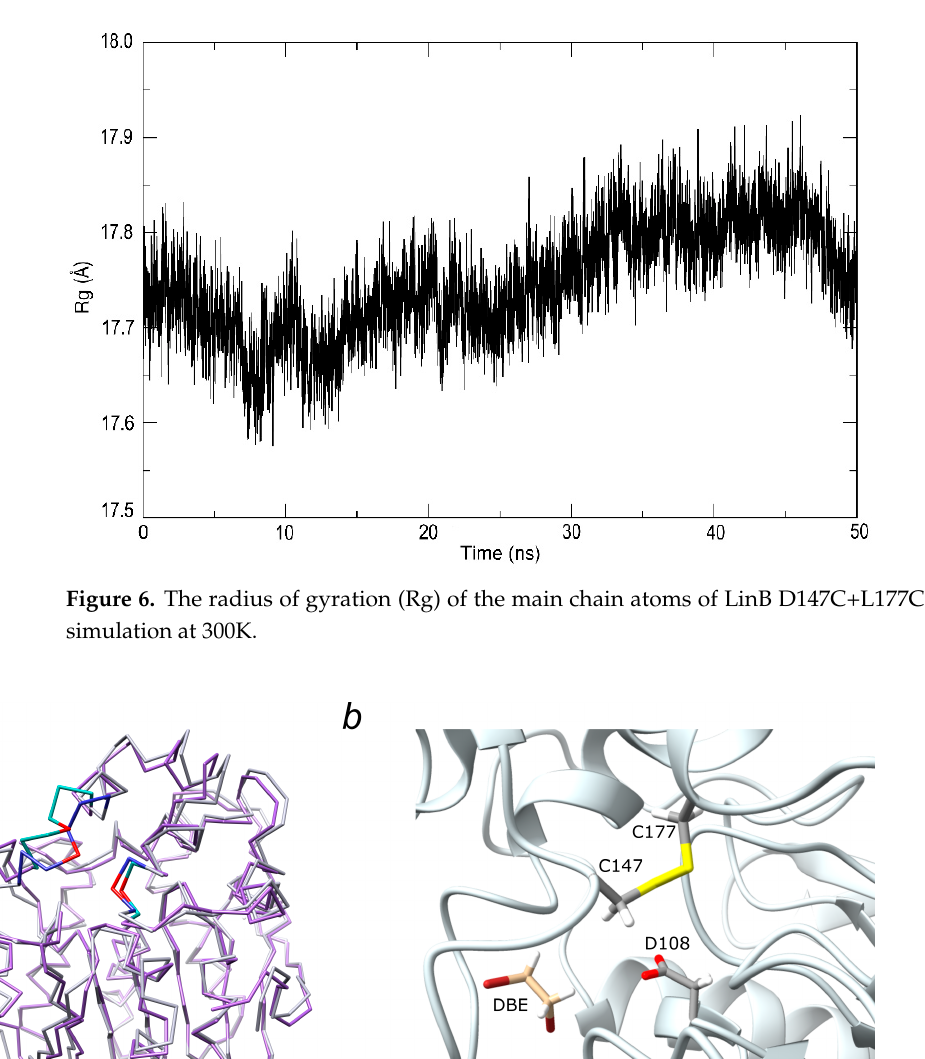
Figure 8. LinB access tunnels in ( a ) LinB WT (PDB ID: 2bfn, [18]), ( b ) LinB D147C+L177C crystal structure (PDB ID: 6s06, this study), and ( c ) LinB MD D147C+L177C model. Tunnels p1a, p1b, and p2 are shown as light blue, magenta, and orange, respectively. The residues W140, F143, L177, and I211 are shown as blue sticks, while the substitutions D147C and L177C are shown as red sticks. The protein chain is shown as a grey ribbon. In the crystal structure of LinB D147C+L177C, CAVER calculations [9,30] revealed the presence of two tunnels: p1b and p2. The width of both tunnels increased by 0.16 Å for p1b and by 0.1 Å for p2 tunnel compared with LinB WT (PDB ID: 2bfn, [18]). The p1a tunnel was not observed in the structure even with a smaller probe radius (Figure 8b). In the structure, C147 located in the mouth of the main tunnel is pulled away from C177 due to the crystal packing effect (Figure 3a). This causes the disruption of the disulfide bond between C147 and C177 and, therefore only partial closure of the main tunnel.